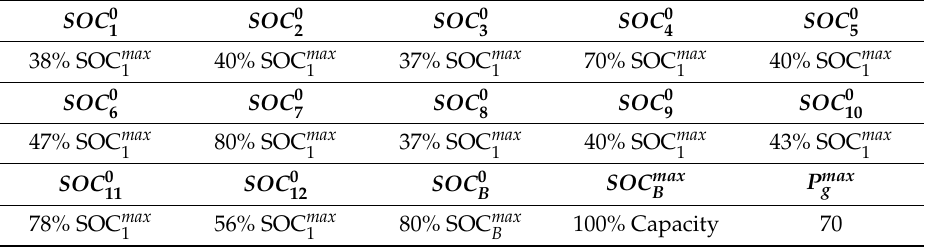
Table 3. EVs and BESS